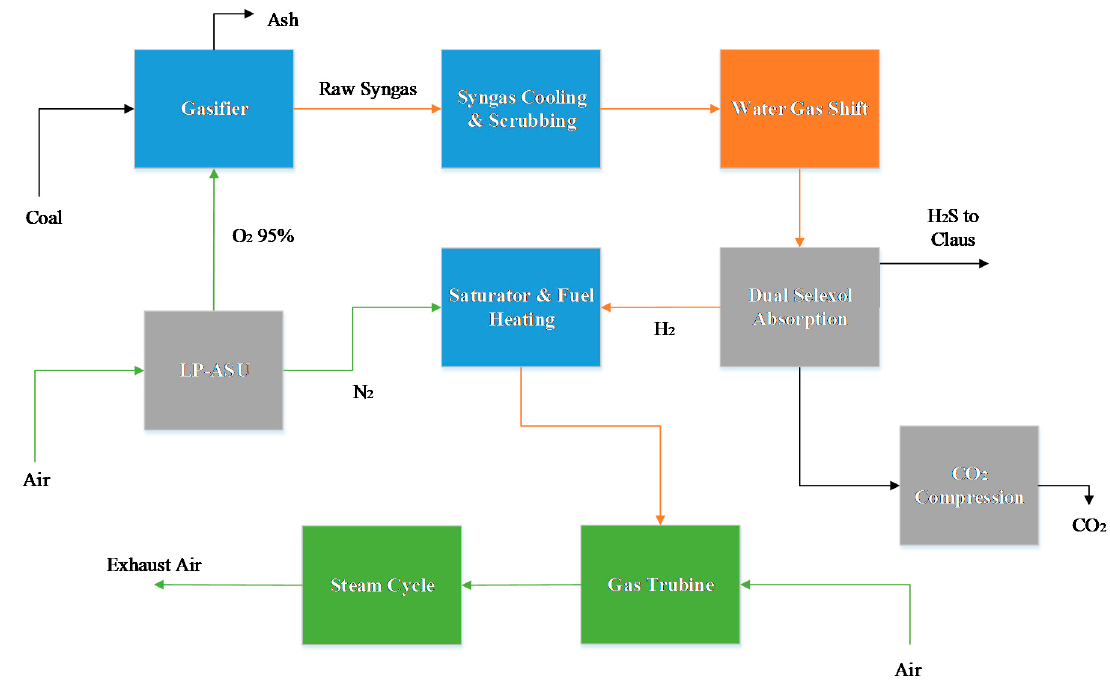
Figure 3. Block flow diagram of the IGCC with pre-combustion CO 2 capture benchmark.